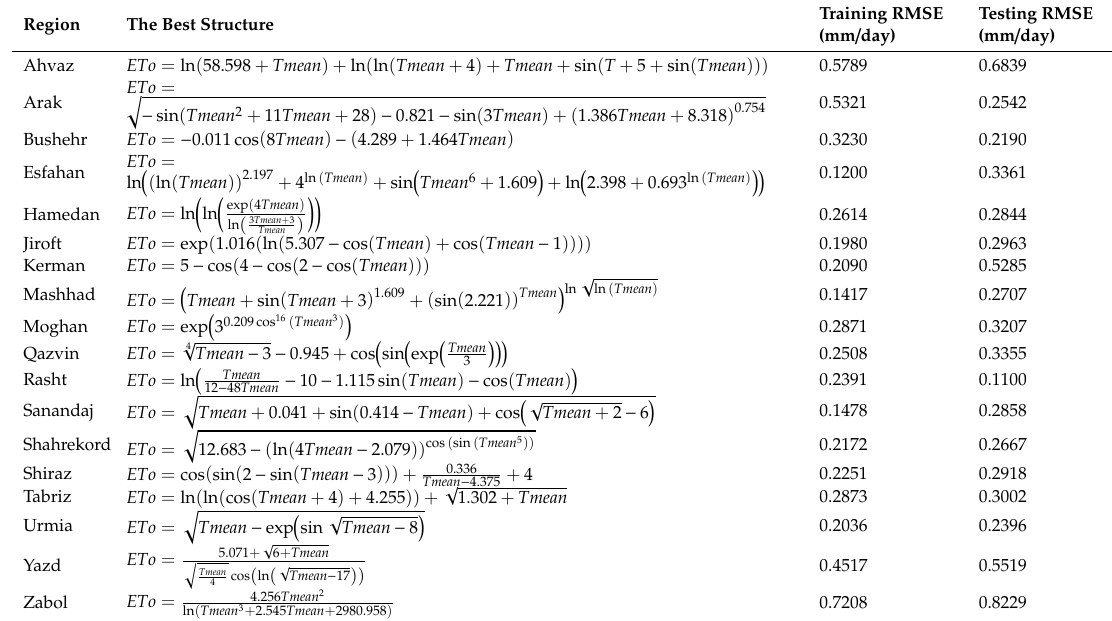
Table 7. Performance of gene expression programming (GEP) for mean temperature (Tmean) as input data.